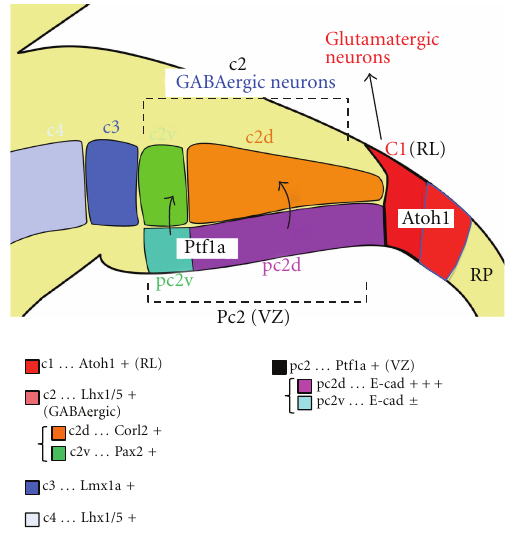
Figure 2: Domain structure of the cerebellar primordium. The c1 domain, expressing Atoh1, corresponds to the rhombic lip that produces all types of glutamatergic neurons in the cerebellum. The pc2 is the Ptf1a-expressing neuroepithelial domain that generates all types of GABAergic cerebellar neurons. At early neurogenesis stages, such as E12.5, the pc2 domain can be subdivided into pc2d and pc2v subdomains, which expresses E-cadherin strongly and weakly, respectively. The c2 domain, expressing Lhx1/5, consists of immature GABAergic neurons putatively generated from pc2 neuroepithelial domain. This domain can also be subdivided into two subdomains, c2d and c2v, corresponding to pc2d and pc2v, respectively. The c2d subdomain consists of corl2-expressing neurons or Purkinje cells, whereas the c2v subdomain includes Pax2-positive cerebellar GABAergic interneurons. Although c3 and c4 domains are Lmx1a and Lhx1/5 positive, respectively, cell types that consist these domains are unknown. The roof plate (RP) is located most dorsally and plays prominent roles in organizing this cerebellar domain